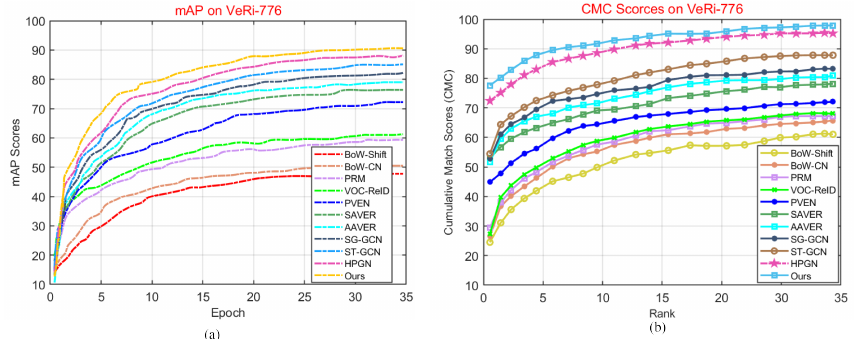
Figure 6. The mAP and CMC curve comparison of our method and several state-of-the-art approaches on VeRi-776 dataset. ( a ) mAP curve comparison on the VeRi-776; ( b ) CMC curve comparison on the VeRi-776.